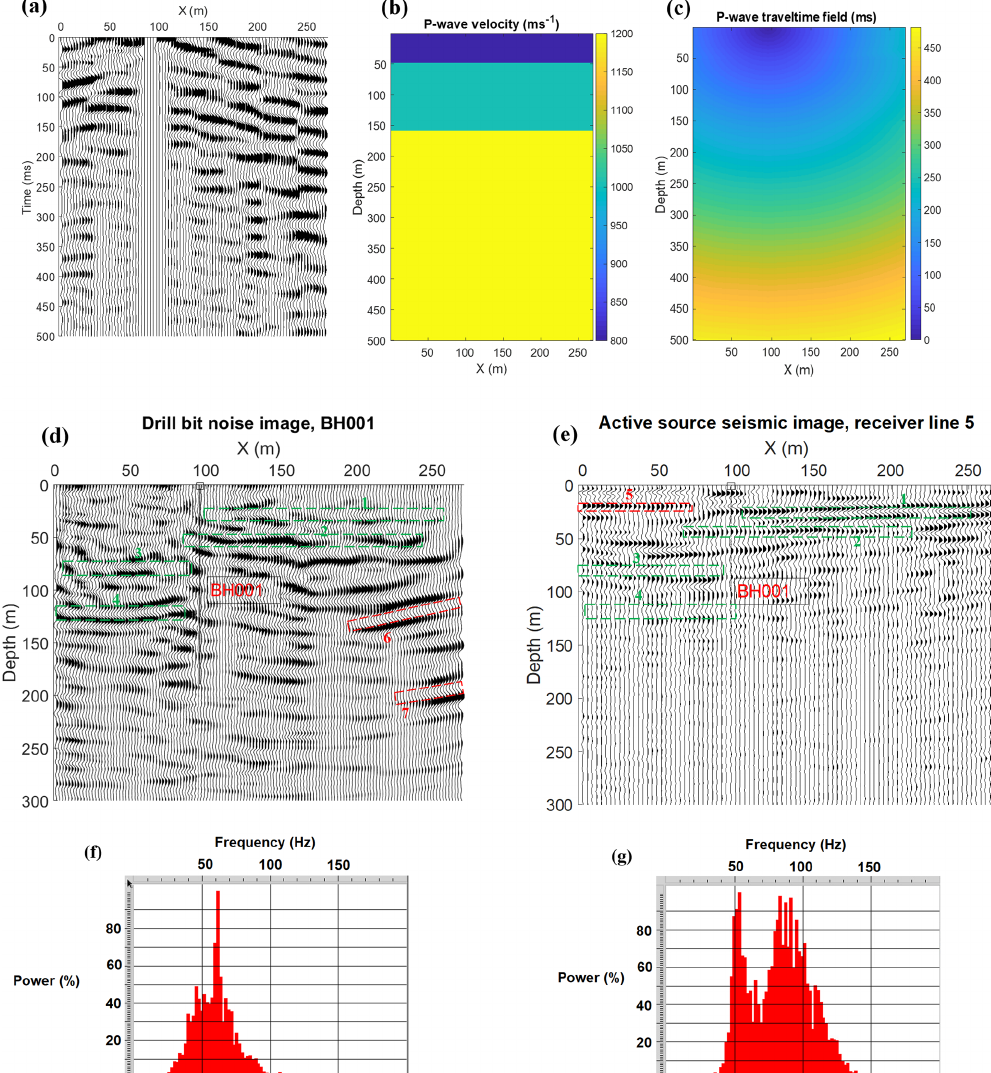
Figure 5. (a) Virtual source at the location of well BH001. (b) Velocity model used in depth migrating drill bit noise and depth conversion of active source seismic volume. (c) P-wave travel time field computed for the virtual source at the location of well BH001. (d) The results of drill bit noise migration in depth. (e) Active source seismic image extracted from a depth-converted volume along receiver line 5. Panels (f) and (g) show the average (and normalized) power spectrum of the passive image and active source image,